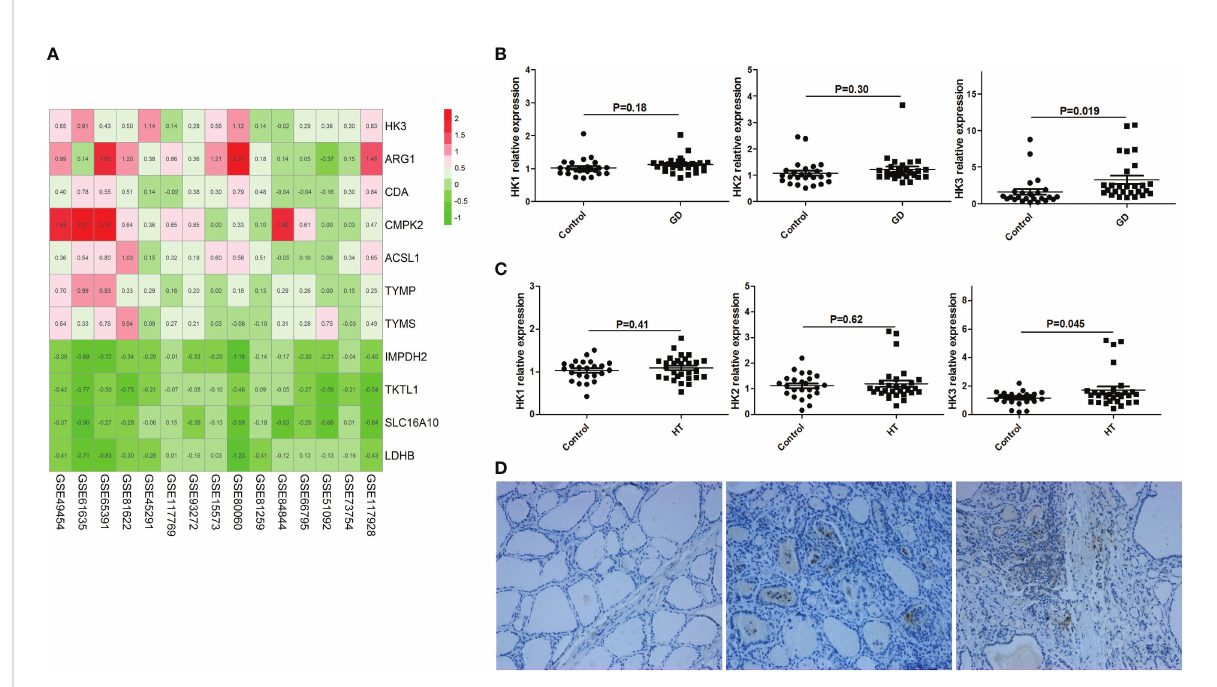
FIGURE 6 HK3 was highly expressed in PBMCs and thyroid tissue of AITD. (A) RRA analysis (HK3 was the most signi fi cant key metabolic gene); (B) mRNA expression of HK1, HK2 and HK3 in PBMCs of GD patients; (C) mRNA expression of HK1, HK2 and HK3 in PBMCs of HT patients; (D) Immunohistochemical results of HK3 in controls, HT and GD patients in